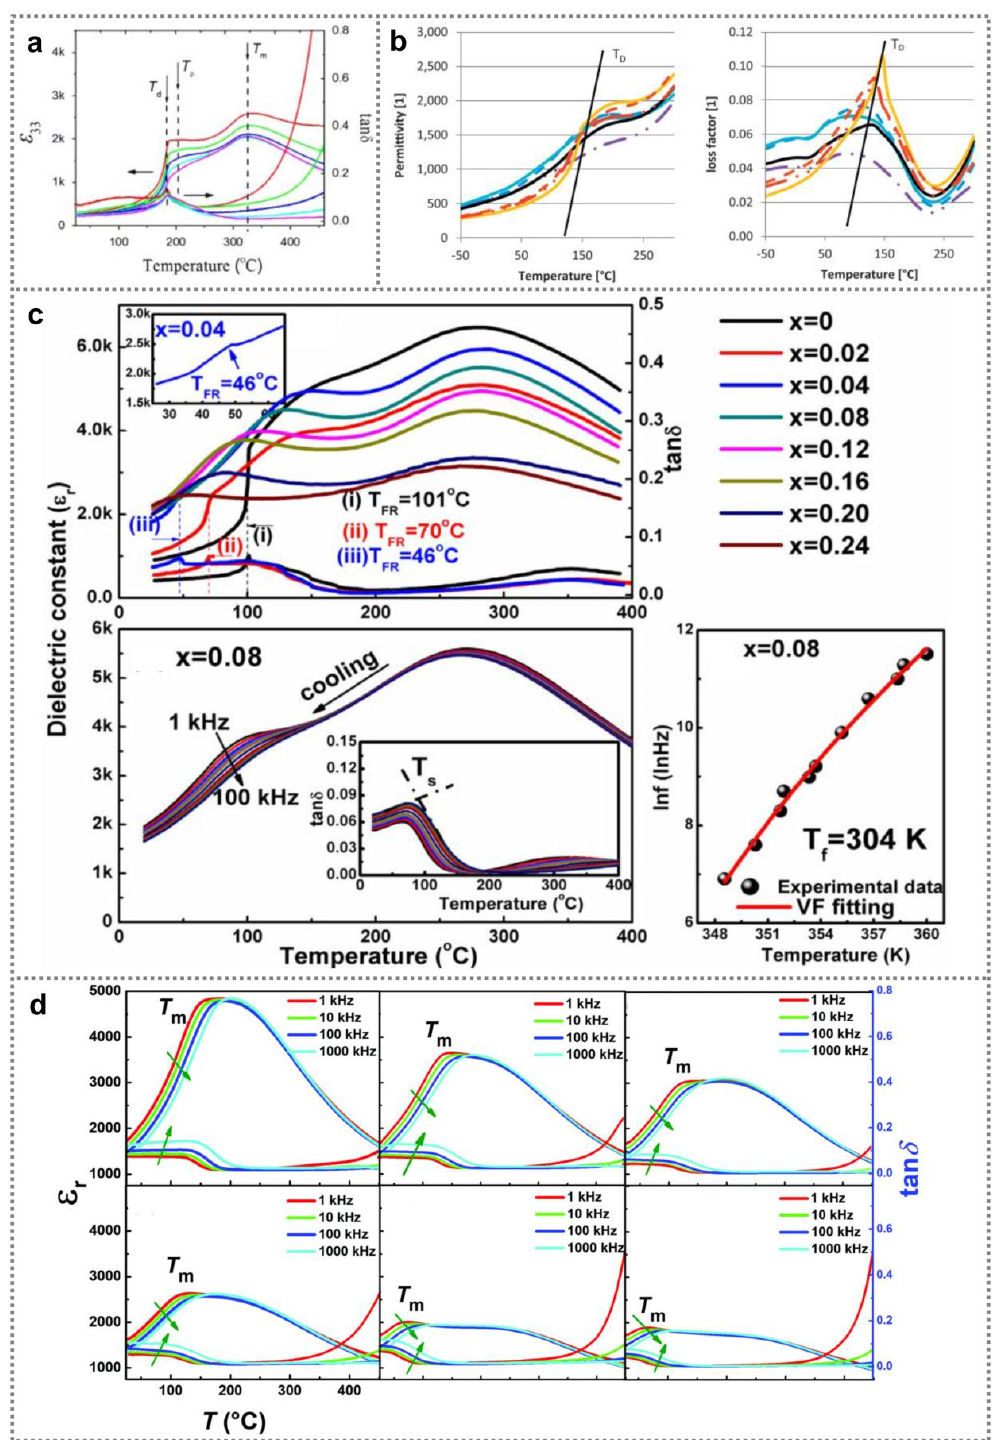
Figure 3. Dielectric property of BNT ferroelectric nanomaterials. ( a ) Typical dielectric constant and loss factor of BNT-based ceramic samples (Reproduced with permission from [58], Elsevier, 2014). ( b ) Dielectric constant and loss factor of BNT ceramic samples containing various amount of Ti (Reproduced with permission from [50], Elsevier, 2014). ( c ) Dielectric constant as well as dielectric loss of BNT-BT-xSBT ceramics containing various amount of SBT, and frequency-dependent dielectric property of BNT-BT-0.08SBT ceramic samples (Reproduced with permission from [54], Elsevier, 2017). ( d ) Dielectric properties of BNT-ST-100xAN ceramics with different AN content (Reproduced with permission from [23], RSC advances, 2018).